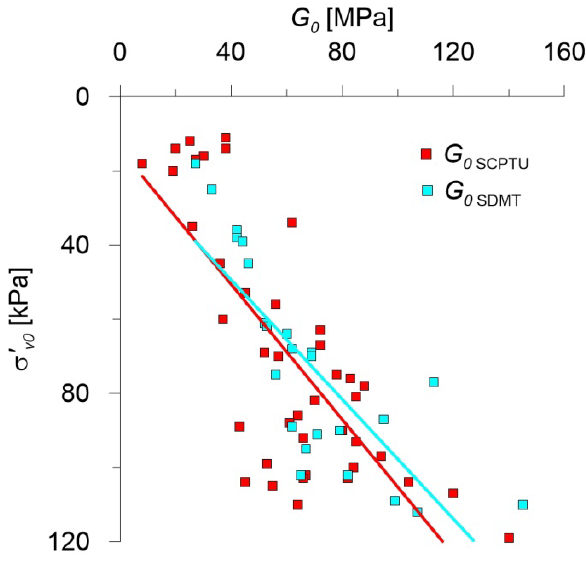
with depth for SCPTU 0